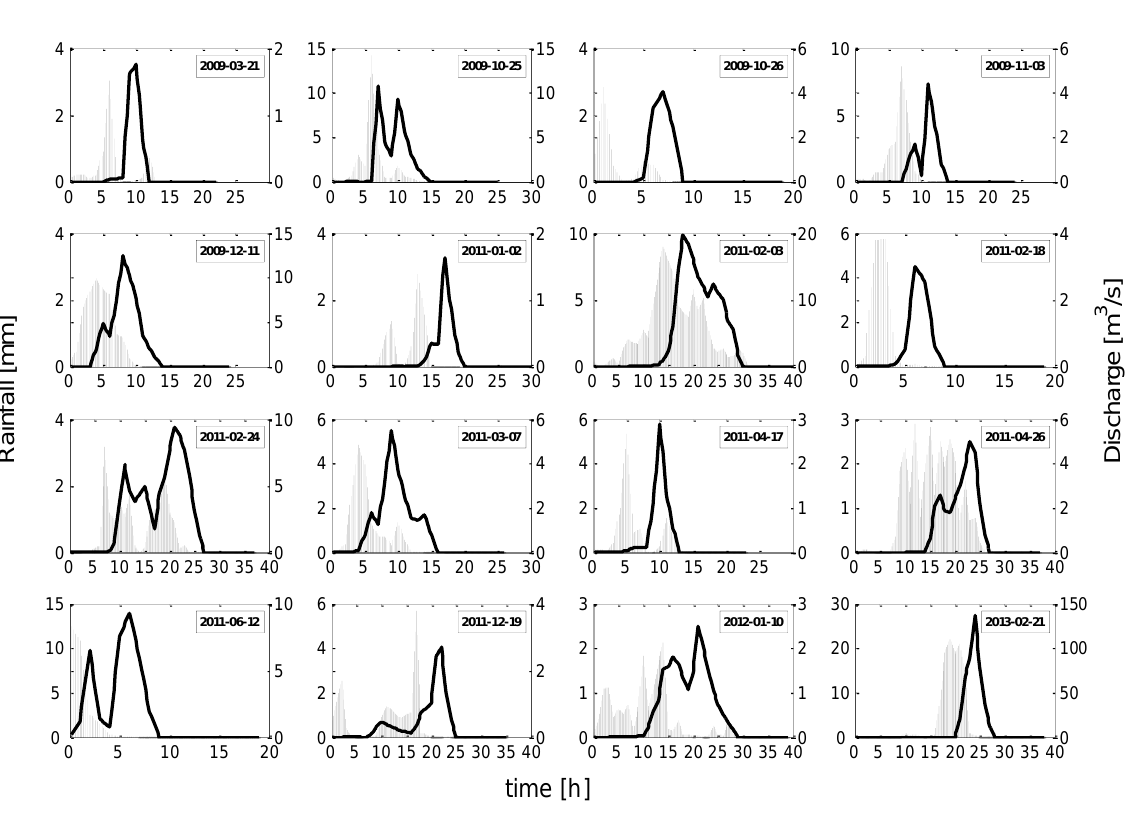
Fig. 2. Observed rainfall and discharge for the selected flood